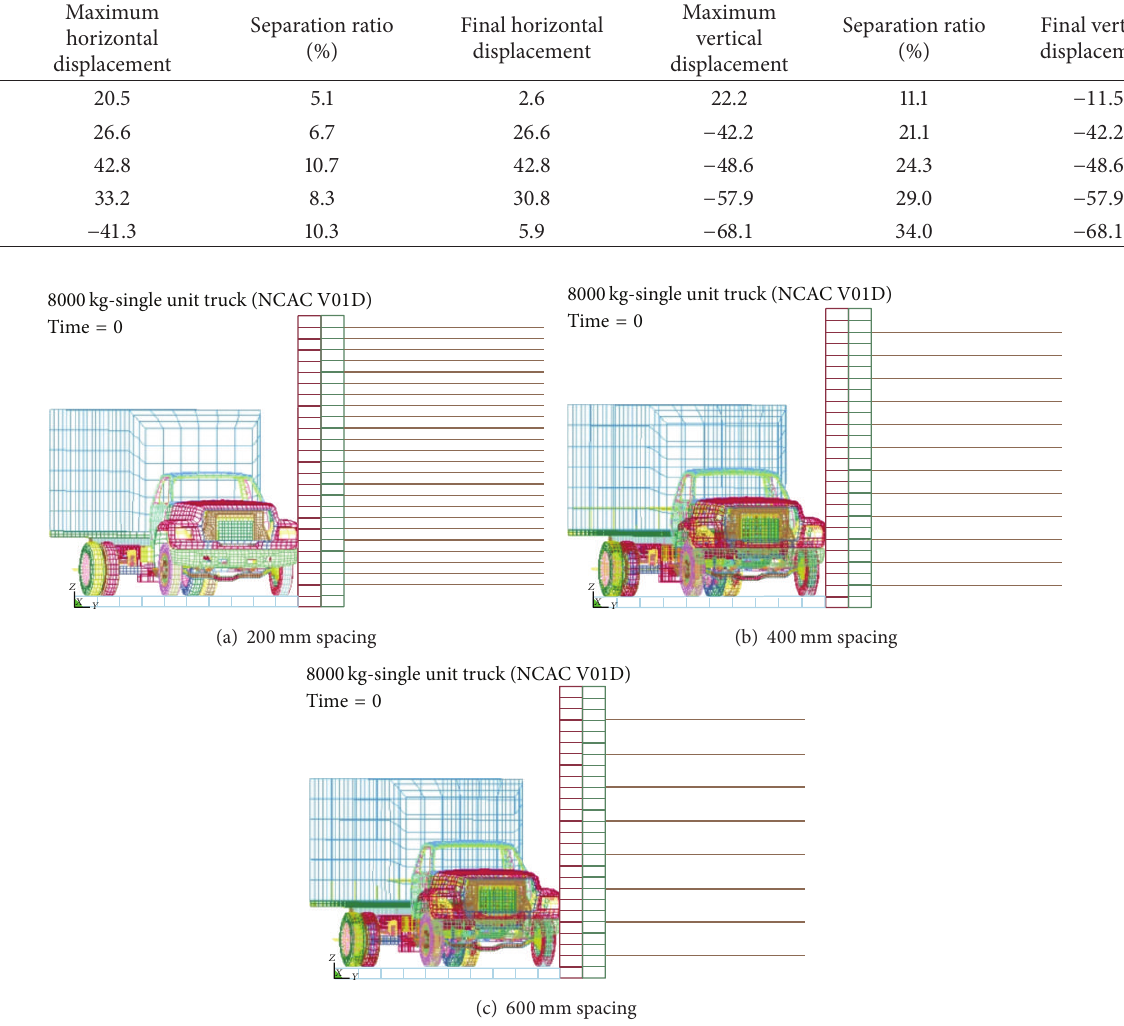
Figure 4: Analysis model for different reinforcement